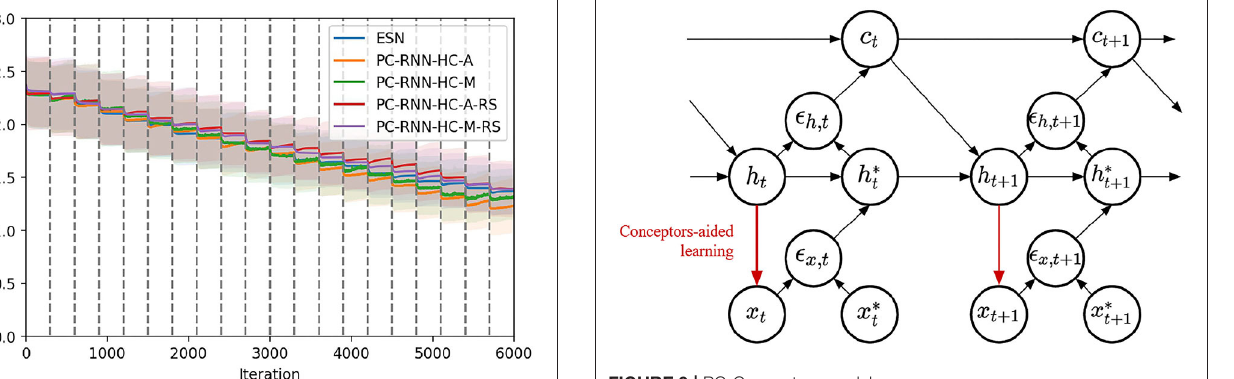
FIGURE 8 | Comparison between the three learning methods for the input weights. The PC-RNN-V model, where no learning is performed on the input weights, is also displayed as a baseline. The 20 tasks are delimited by the dashed gray lines.